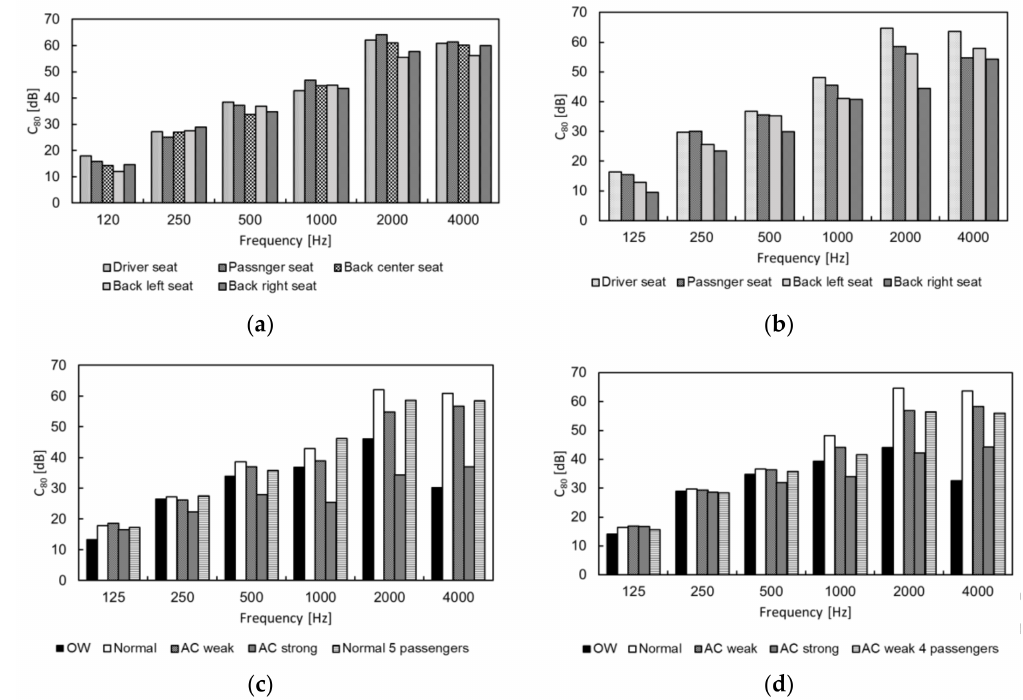
Figure 6. Measured C 80 [dB] at each passenger position in cars ( a ) A and ( b ) B and under open-window (OW), air-conditioner (AC) and multiple passenger settings in cars ( c ) A and ( d )